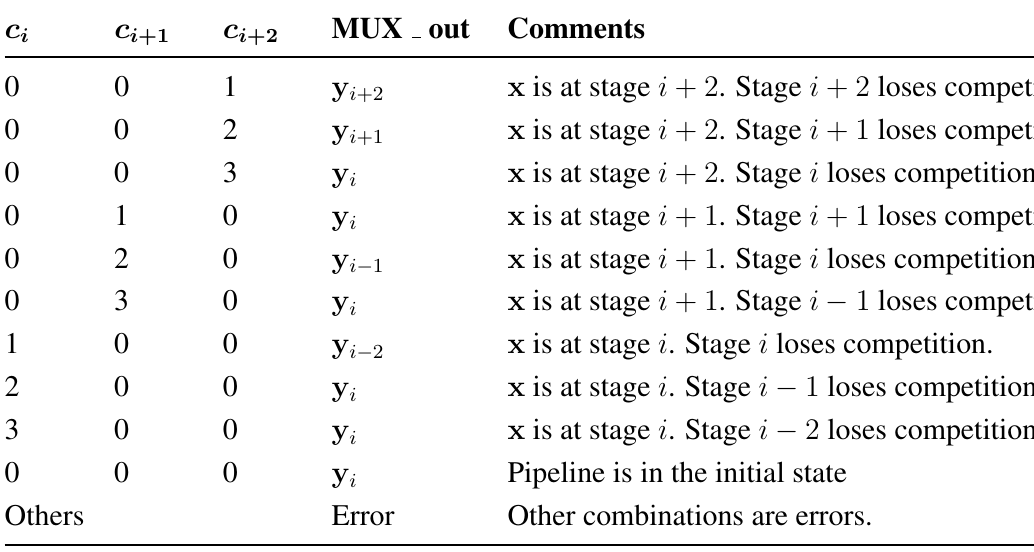
Table 1. The truth table for the multiplexer in the swap unit at stage i for k = 2